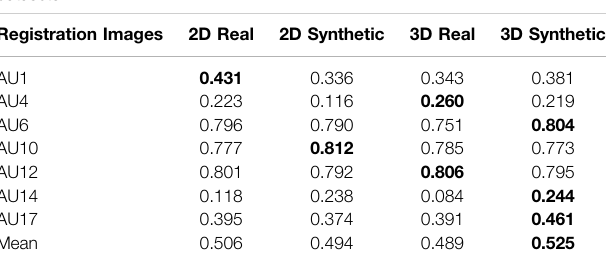
TABLE 2 | Comparison of synthetic vs. real expressions under 2D vs. 3D alignmentonFERA2017Testpartition.ScoresareInter-raterreliability(ICC)of AU intensity level estimation. The Images row shows which is used to train classi fi ers: Real or Synthetic. All of the classi fi ers were tested on the real test dataset. The same Registration (2D or 3D) were applied to both train and test